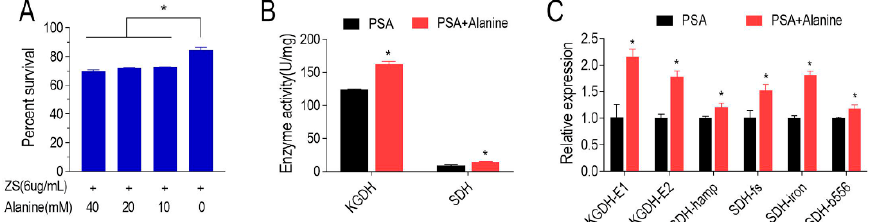
Figure 5. Exogenous alanine enhances the killing efficiency of ZSM and promotes the P cycle in ZSM-resistant Xoo. ( A ) The percent survival of ZSM-resistant Xoo in the PSA broth with gradient dosages of alanine from 0 to 40 mM. ( B ) Activities of KGDH and SDH in the ZSM-resistant Xoo in the presence or absence of 40 mM alanine. ( C ) The expression level of genes encoding KGDH and SDH in ZSM-resistant Xoo in the presence or absence of 40 mM alanine. The results are displayed as mean with SD, and significant differences are identified as determined by Student’s t -test (* p < 0.05). At least three biological replicates were carried out.